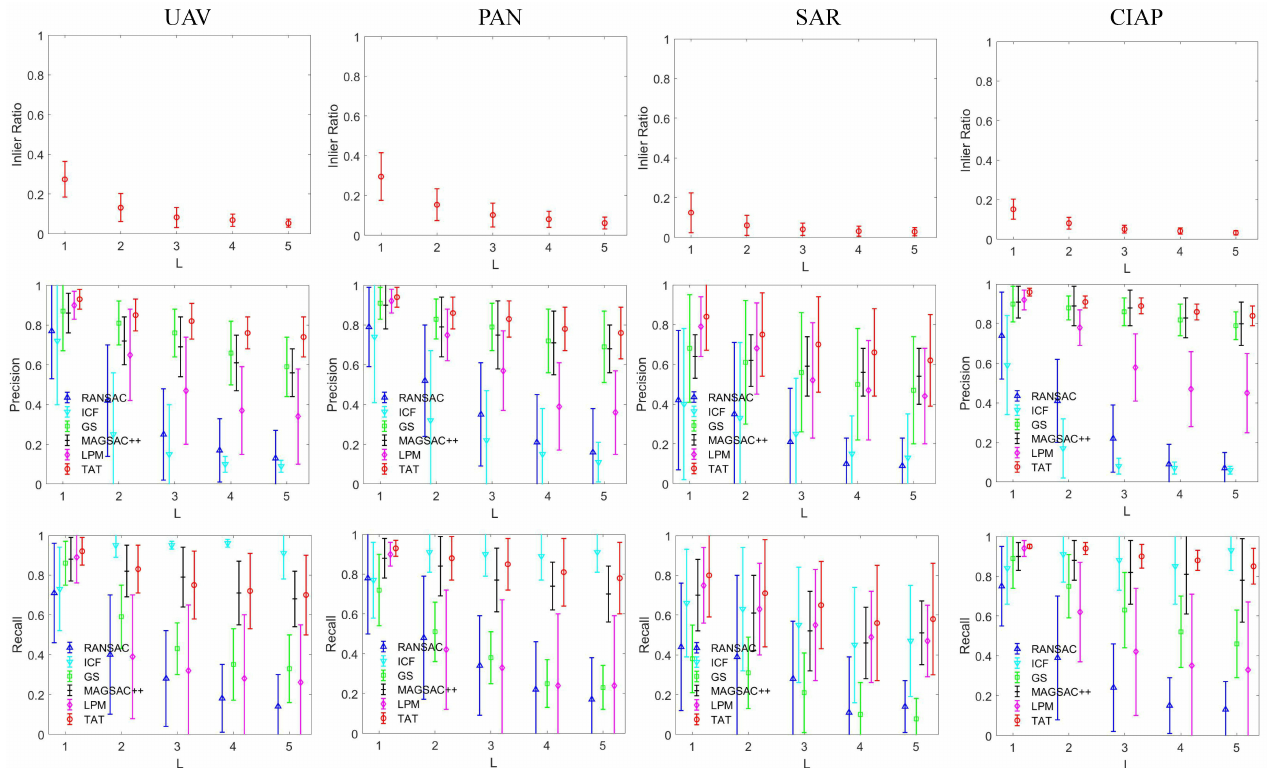
Figure 9. Robust test of RANSAC [13], ICF [40], GS [47], MAGSAC++ [48] LPM [16], and TAT on four test datasets, such as UAV, PAN, SAR, and CIAP. (Top to Bottom) Initial inlier ratio, precision, recall with respect to different values of L, i.e., the number of nearest neighbors used for putative set construction. Error bars: means and standard deviations on the corresponding